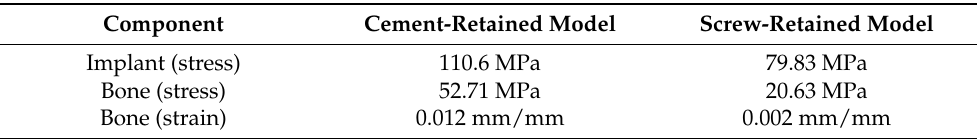
Table 4. Maximum von Mises stress and strain values in the implant and surrounding bone under 100 N oblique load in the finite element model.